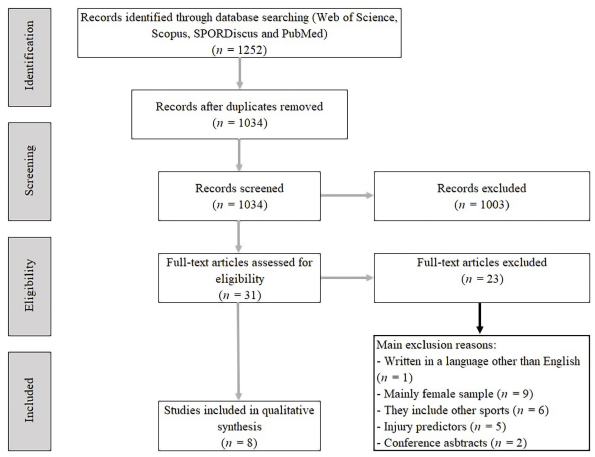
Fig. 1. PRISMA flow chart highlighting the selection process of the studies included in the umbrella